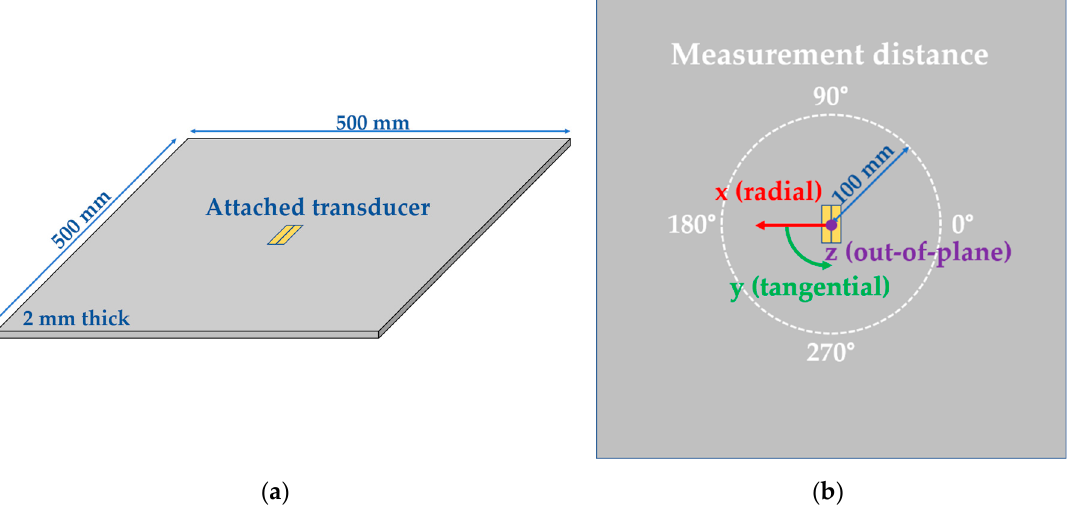
Figure 11. The modeling configuration. ( a ) General view; ( b ) top view. The size of the steel plate was 500 × 500 × 2 mm 3 , and the transducers were always located at the center. The red, green, and purple arrows indicate the radial (x), tangential (y), and out-of-plane (z) axes of the cylindrical coordinate system. The symbols (x,y,z) for the cylindrical coordinates were chosen to be in accordance with the output of ANSYS (compare Figure 14). The emitted waves were measured at a distance of 100 mm from the center.